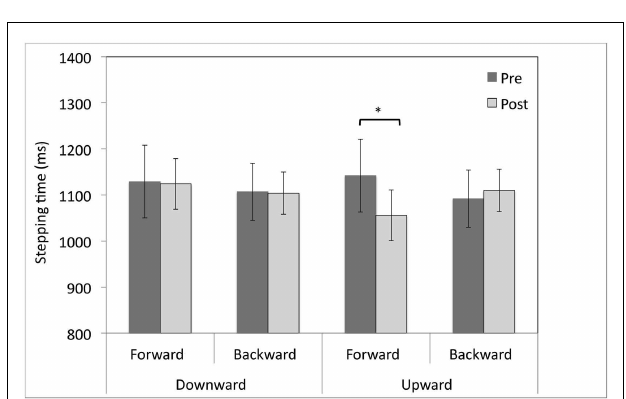
FIGURE 2 | Pre- and post-adaptation reaction times (ms) for forward and backward stepping for healthy participants after 20min of adaptation to upward- or downward-shifting prisms. * p < 0.05, error bars represent ± 1 SEM.